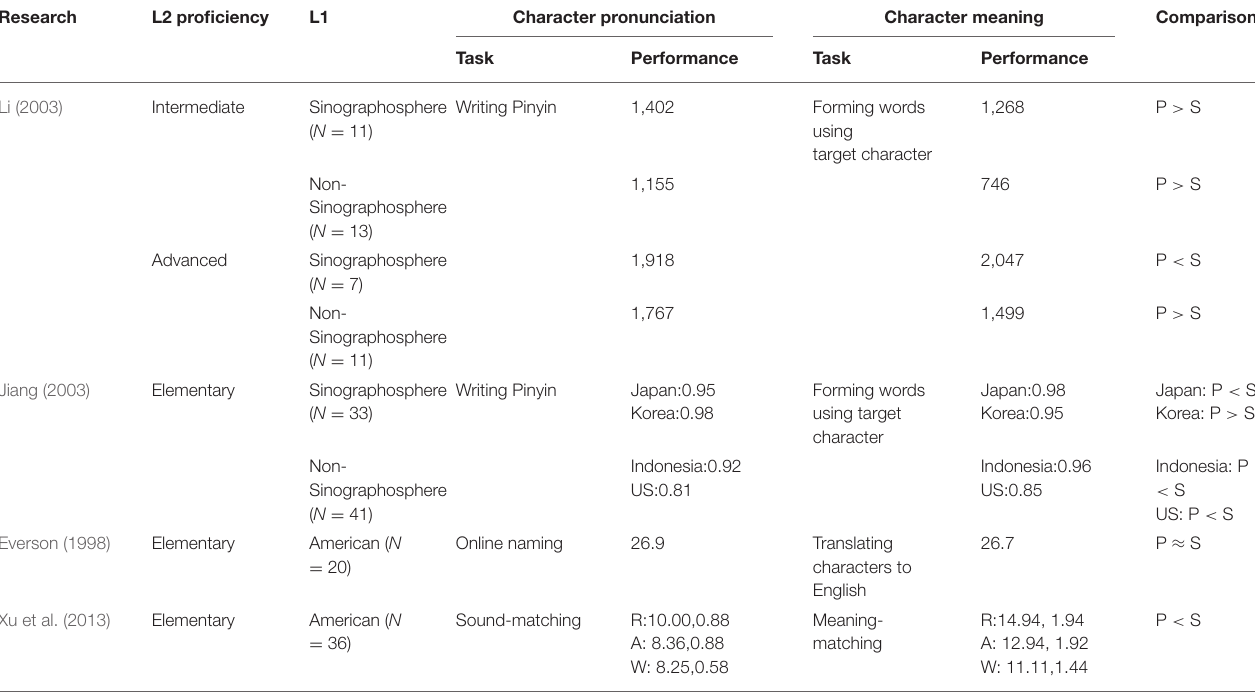
TABLE 1 | Summary of CSL learners’ performance in character pronunciation and meaning in previous studies.